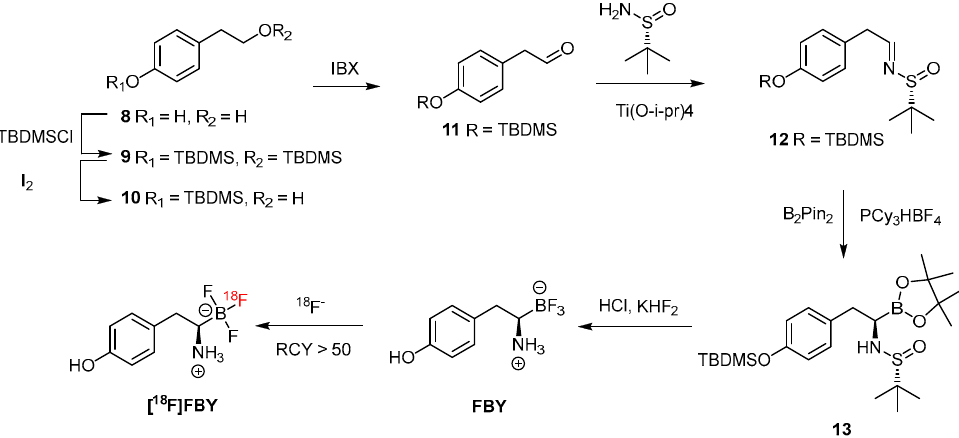
Scheme 7. FBY and [ 18 F]FBY generated through a facial synthetic route comprising a step of HPLC